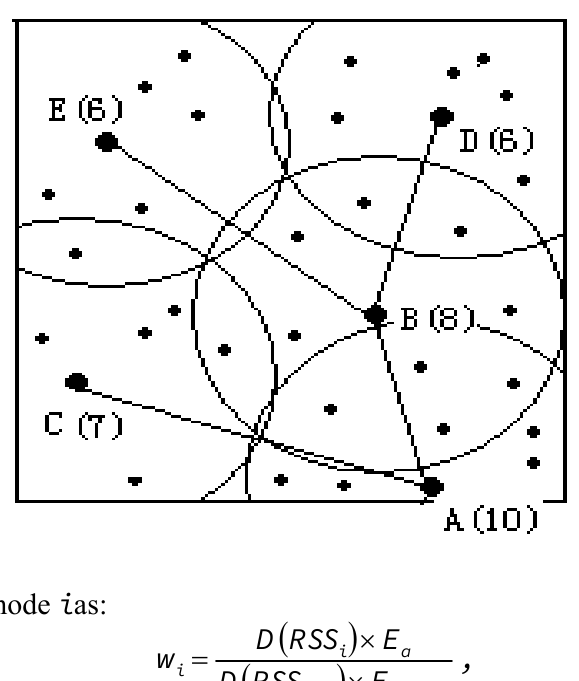
Figure 6. Routing tree